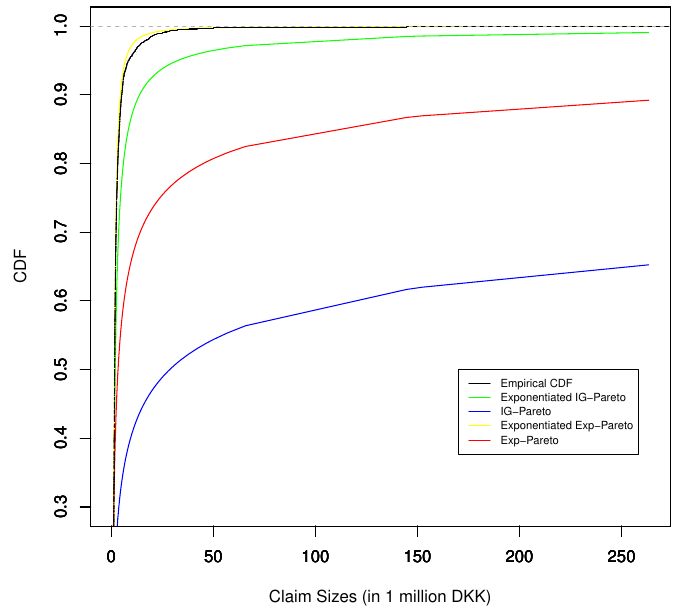
Figure 5. The empirical CDF of Danish fire insurance data and the fitted CDF, of corresponding exponentiated IG-Pareto, IG-Pareto, exponentiated exp-Pareto, and exp-Pareto model